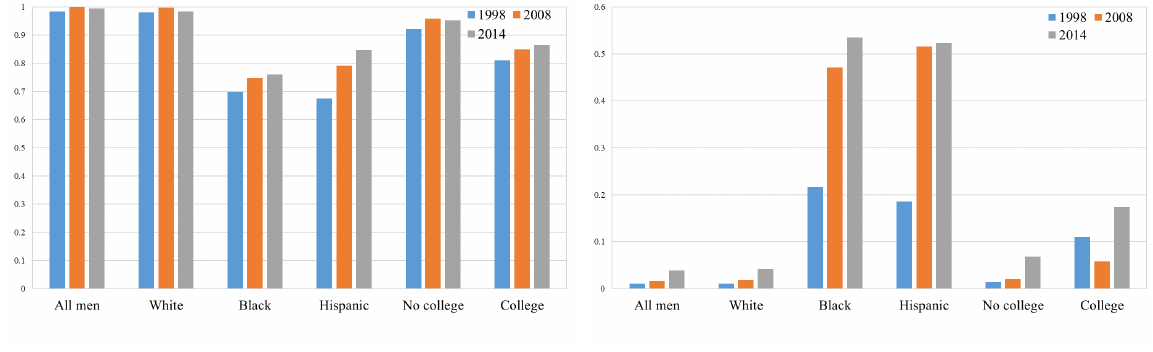
Figure 3: Connectedness of full binary networks and networks restricted to ties with monthly probabilities greater than 0.005 for different sociodemographic groups, 1998 to